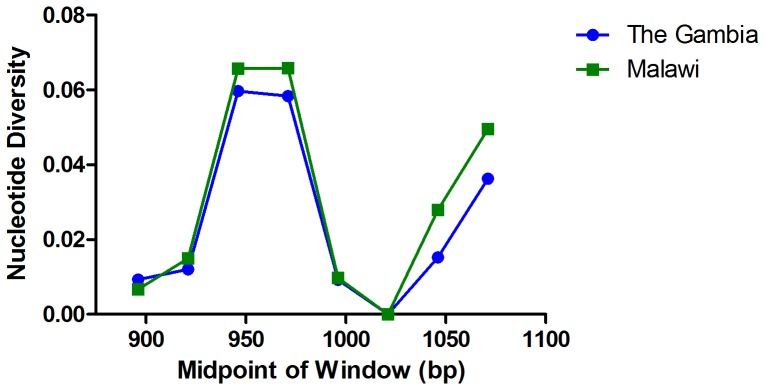
Nucleotide Diversity of pfcsp from Malawi and the Gambia.The nucleotide diversity (π) was determined for the sequenced region using a sliding window (size: 50 bp, slide: 25 bp). Two peaks in diversity are seen corresponding to the TH2 (bp 897–972) and TH3 (bp 1046–1091) epitopes. The peak level of diversity and pattern of diversity was similar between the two populations.